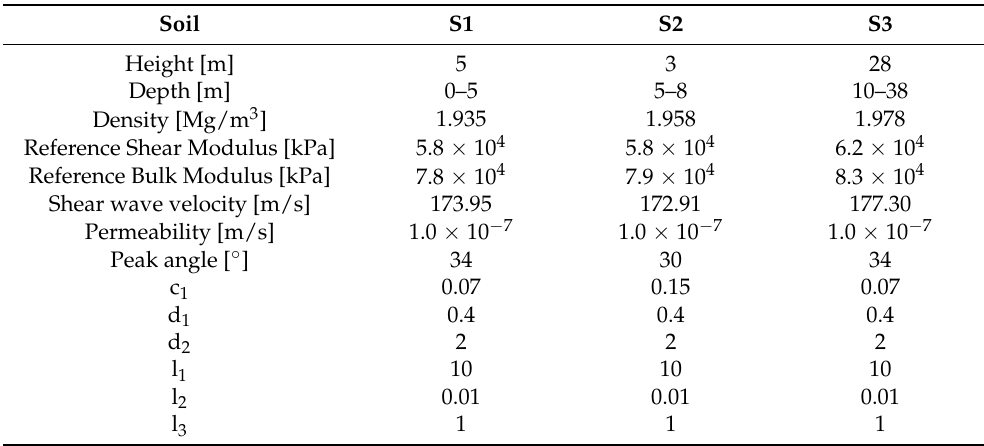
Table 2. Characteristics of soils S1, S2, and